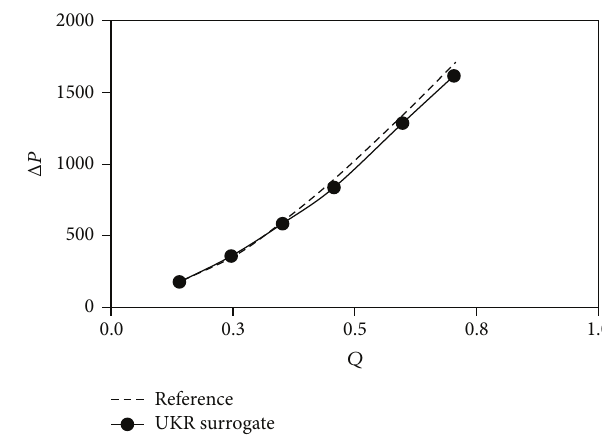
Figure 6: Efficiency enhancement.